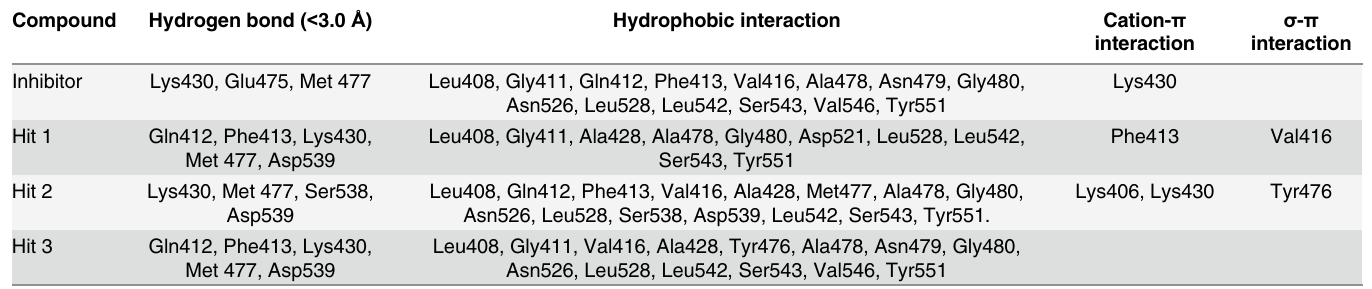
Table 5. The molecular interactions between the compounds and Btk protein. Compound